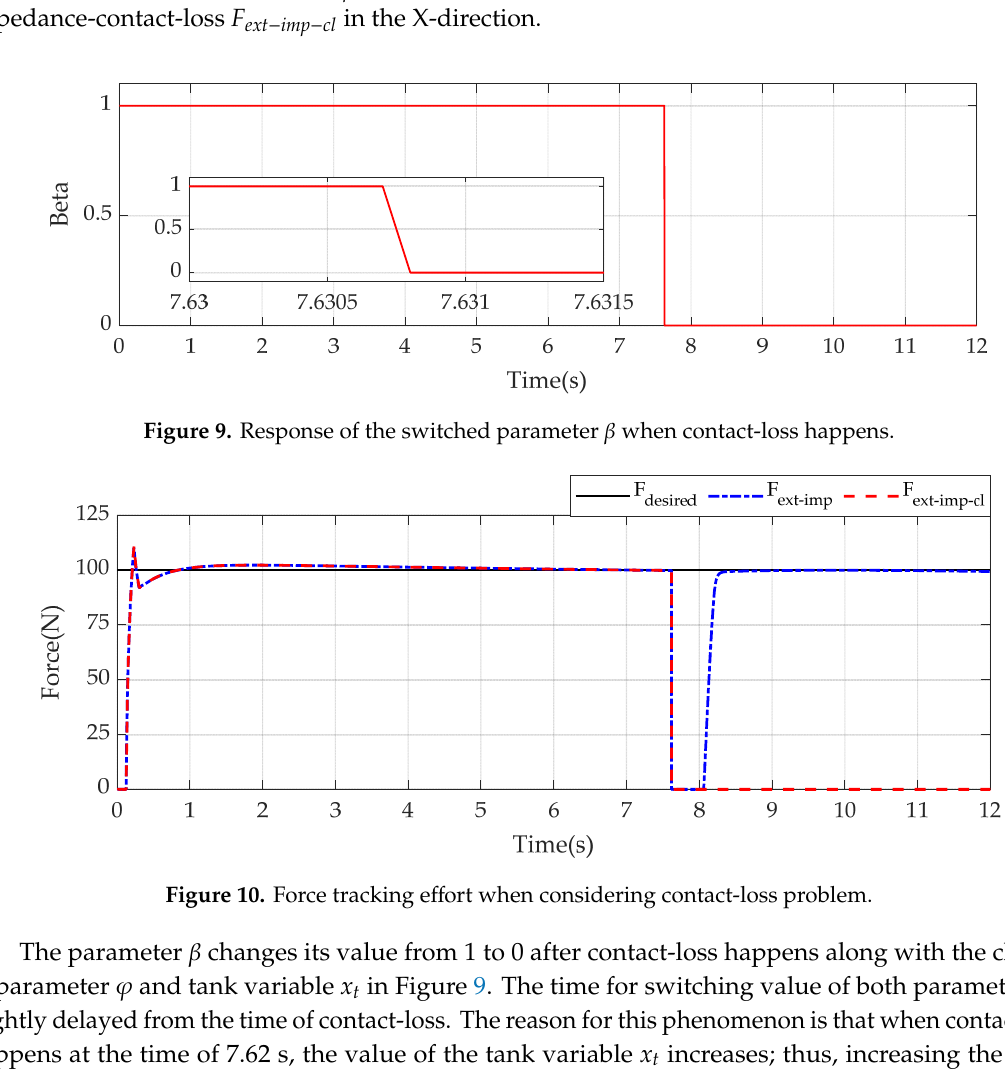
15 of 23 Figure 7. Position tracking effort along the Y-direction. Figure 8. Position tracking effort along the Z-direction. At the time of approximately 7.62 s, the sudden change in the environment framework causes contact-loss. At that time, the interacting force immediately decreases to zero, and the tank variable increases until its energy reaches the upper limit u T at the time of approximately 7.63 s. Then, the parameters β and φ simultaneously switch their values as shown in Figure 9. Due to using the energy tank, the end-effector can generally maintain the same level with a very small position shifted. This